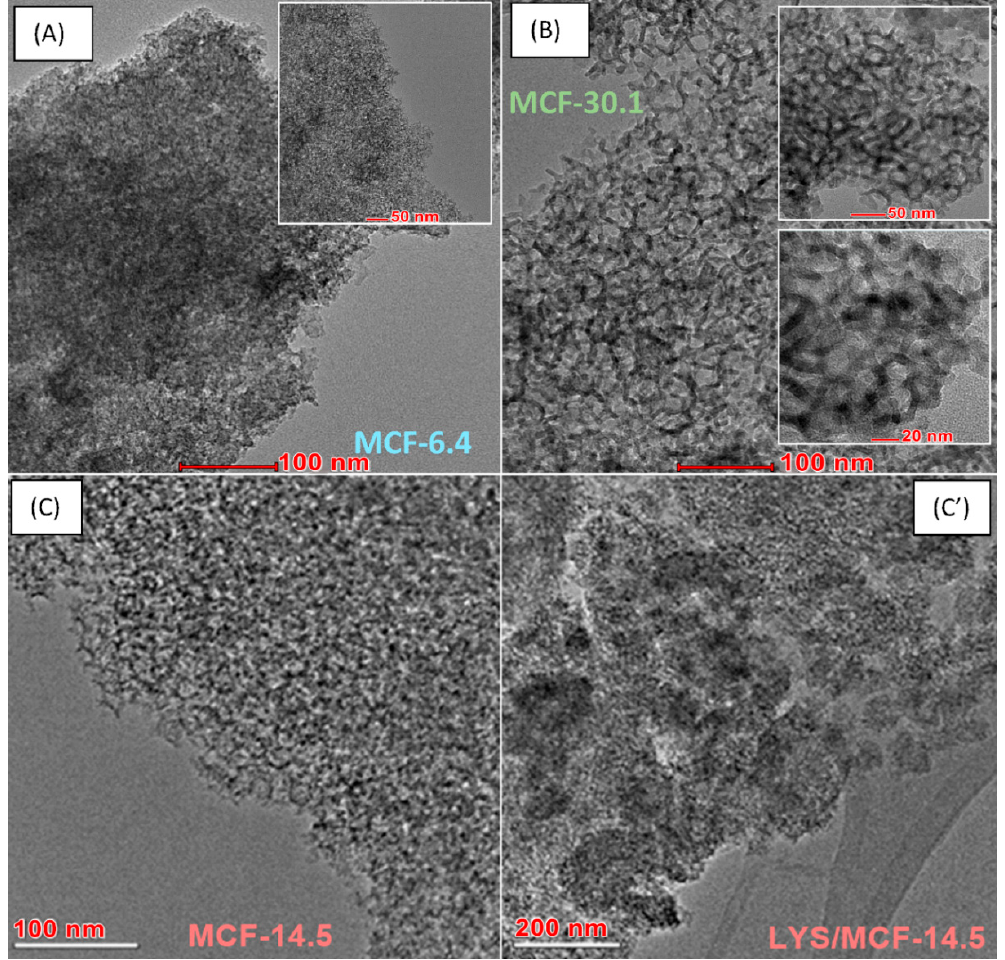
Figure 8. ( A ) HRTEM-BF micrographs showing the surface morphology and nanostructure of the MCF-6.4 ( A ), MCF-30.1 ( B ), and MCF-14.5 support before ( C ), and ( C ’) after immobilization of LYS molecules.